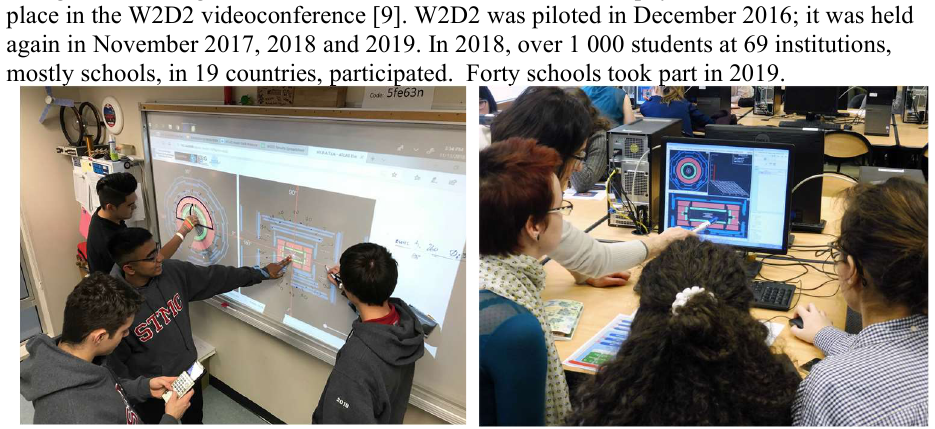
Figure 7. International Day of Women and Girls in